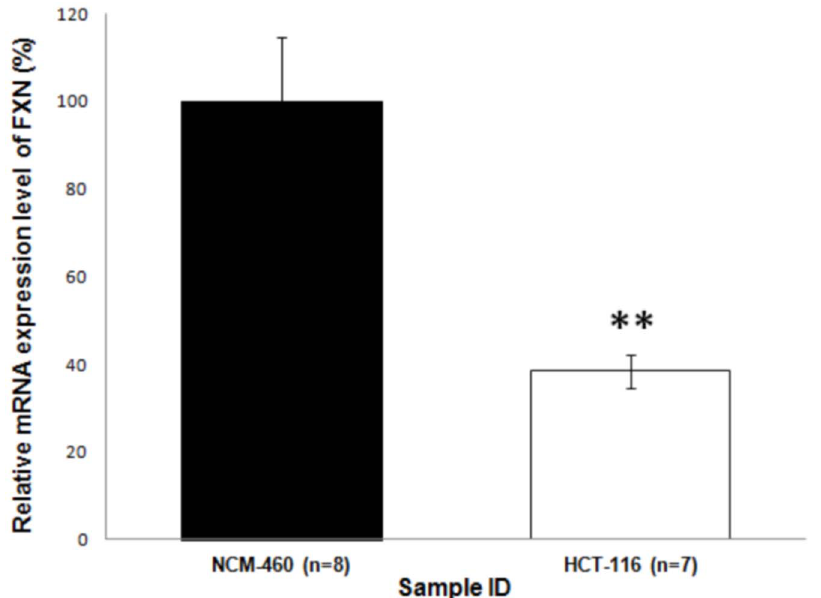
Figure 5. Effect of the MutL a -complex on FXN transcription invitro . Relative RT-qPCR analyses of the mean FXN transcriptional level, isolated from MMR-proficient human cells, NCM-460, and MutL a heterodimer-deficient cells, HCT-116 (n=3). Statistical analysis of the experiment was perform using the student’s t test. Error bars=S.E.M, *=p , 0.05, **=p , 0.01, ***=p , 0.001.